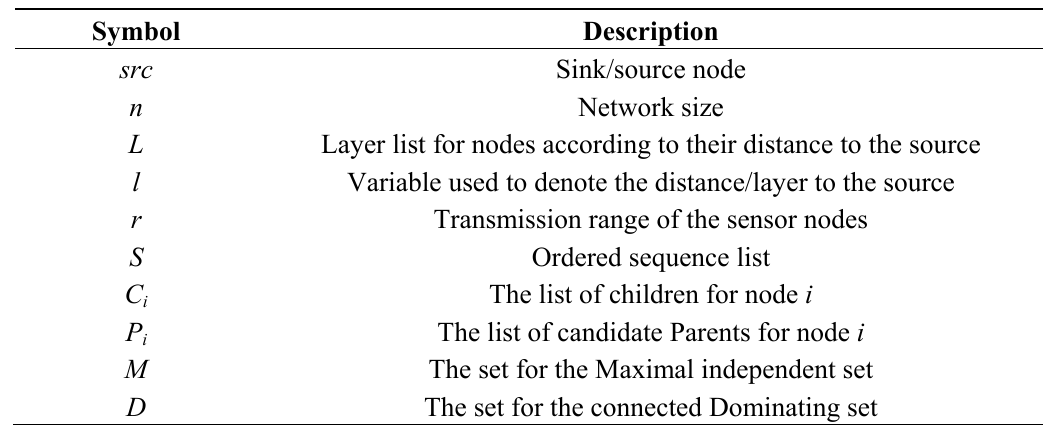
Table 1. Notation of the